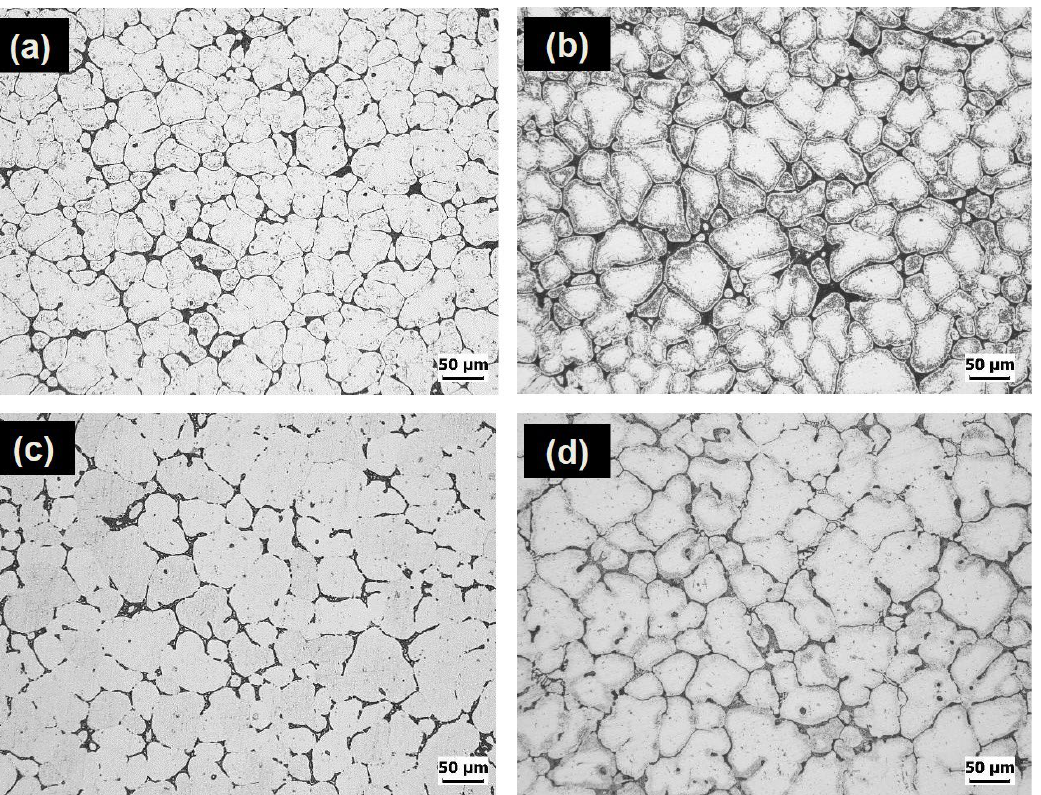
Figure 7. Optical micrographs of the investigated alloys in different temper conditions. Microstruc- tures of the B43 alloy are displayed in ( a , c ), while ( b , d ) show the as - cast and as - quenched micro- structures of the S43 alloy, respectively.